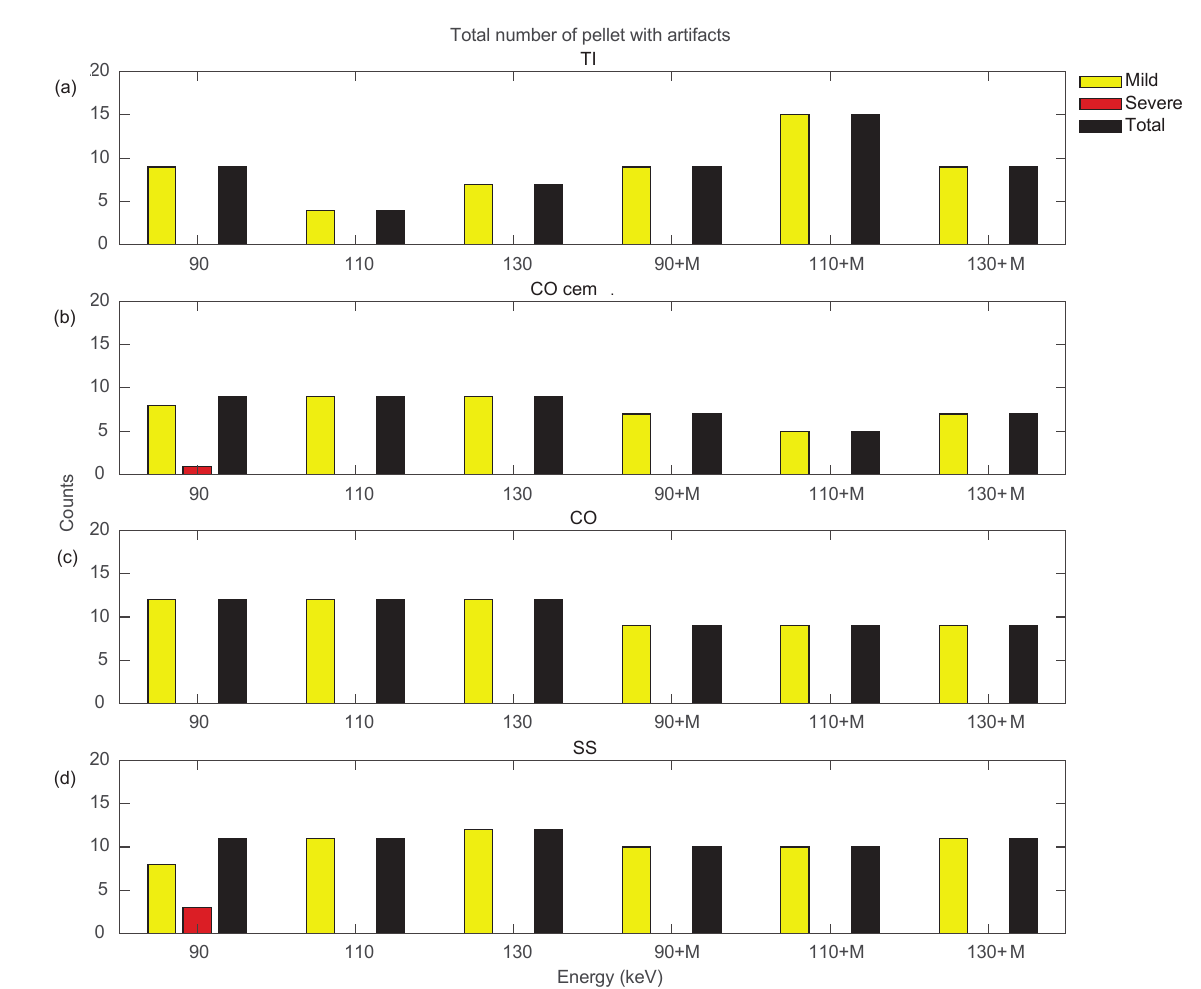
Figure 10. Counts for mild, severe, and total (sum of mild and severe) artifacts in prostheses from unilateral configurations, varying the reconstruction energies (VMI reconstructed without MARS, indicated as 90, 110, and 130, and VMI reconstructed with MARS, indicated as 90+M, 110+M, and 130+M). The counts of mild, severe, and total artifacts are indicated with yellow, red, and black bars, respectively. Results from TI, CO cem., CO, and SS configuration are displayed in panels ( a – d ), respectively.